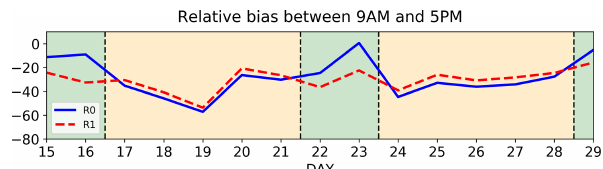
Figure 15. Average diurnal cycle of measured and modeled concentrations of (a) NO ∗ reference 15d simulation (15–29 June) are shown. In the case of NO 2 , both the interference-corrected and uncorrected model outputs are presented.